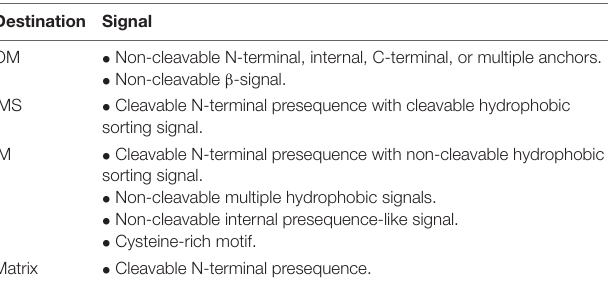
TABLE 1 | Targeting sequences of nuclear-encoded mitochondrial